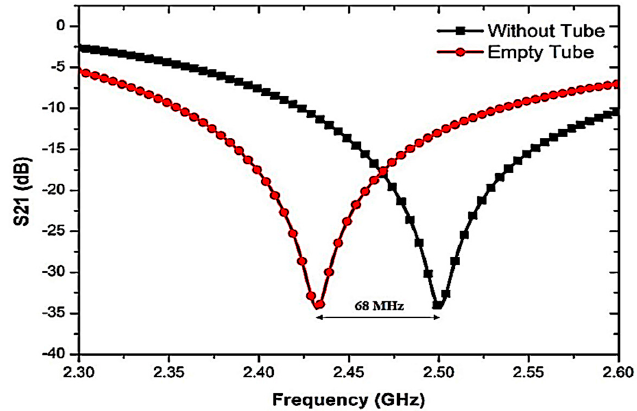
Figure 7. The effect of frequency shifted when the pp tube was loaded into the triple-rings CSRR sensor.